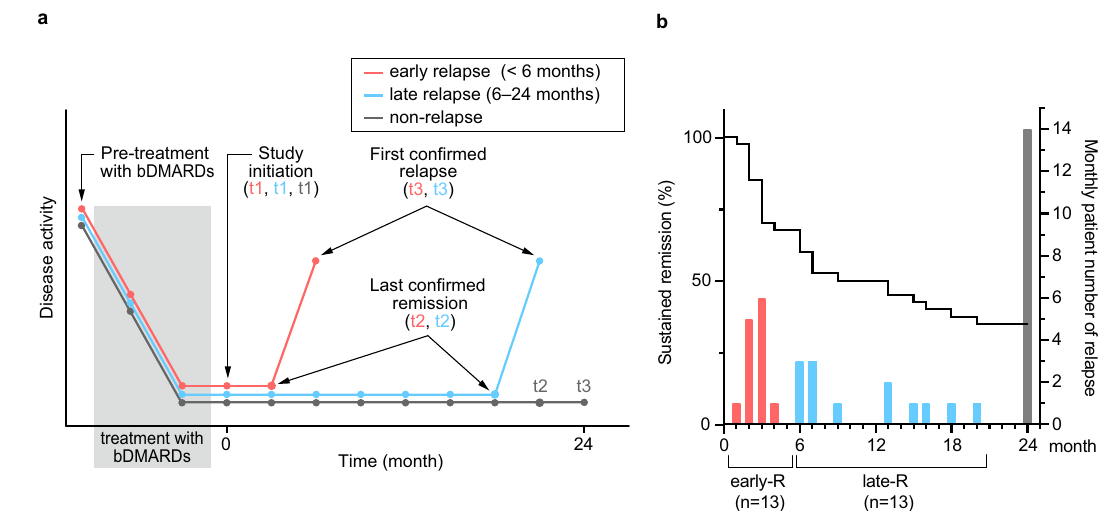
Figure 1. Study design. ( a ) Schema of the timing of clinic visits and serum sampling. The orange–red line indicates a patient group that relapsed earlier than 6 months after bDMARD withdrawal (early relapse). The cyan line indicates a patient group that relapsed within 6–24 months (late relapse). The grey line indicates a patient group with sustained remission for 24 months (non-relapse). t1: time of study initiation (time of bDMARD withdrawal); t2: time of last confirmed remission in relapsed groups or just before study end for a sustained-remission group; t3: time of first confirmed relapse in relapsed groups and study end for a sustained- remission group. The images were created using Adobe Illustrator (ver. 25.4.1, https:// www. adobe. com/). ( b ) Kaplan–Meier curve showing the percentage of patients in remission during the 24-month study span and bars showing the number of newly relapsed patients, with orange–red for early relapses and cyan for late relapses. The number of patients in remission decreased quickly during the first 6 months, and the reduction rate became very slow thereafter. Figure 1b was created using GraphPad Prism 9 (www. graph pad.